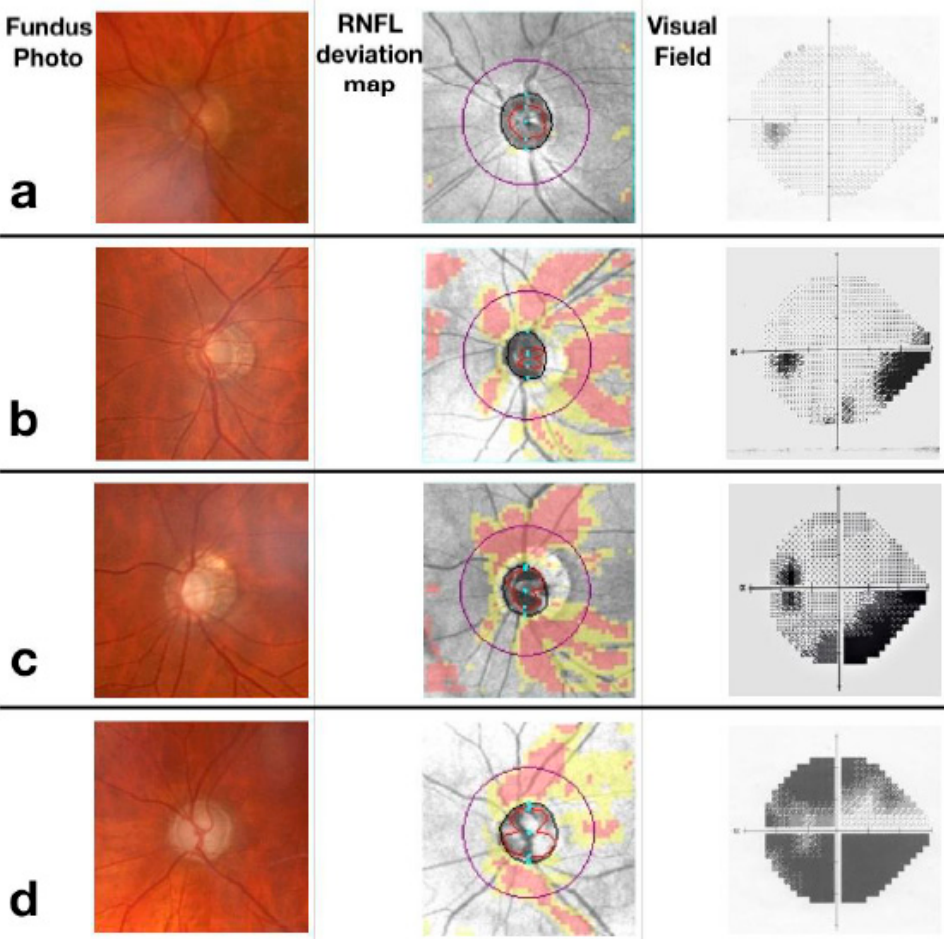
Figure 2. Glaucoma stages. Row ( a ) representation of a normal optic nerve, which presents nerve fibre layers and unaltered visual field. Row ( b ) early-stage glaucoma with initial optic disc excavation at the fundus and loss of nerve fibres more pronounced in the superior sector that determines a nasal step in the visual field. Row ( c ) moderate-stage glaucoma with partial optic disc excavation at the fundus and loss of nerve fibres in the inferior sector, determining an arciform defect in the visual field. Row ( d ) severe glaucoma, characterized by an excavated optic disc, loss of nerve fibres in both superior and inferior sectors and absolute defects in all sectors of the visual field.